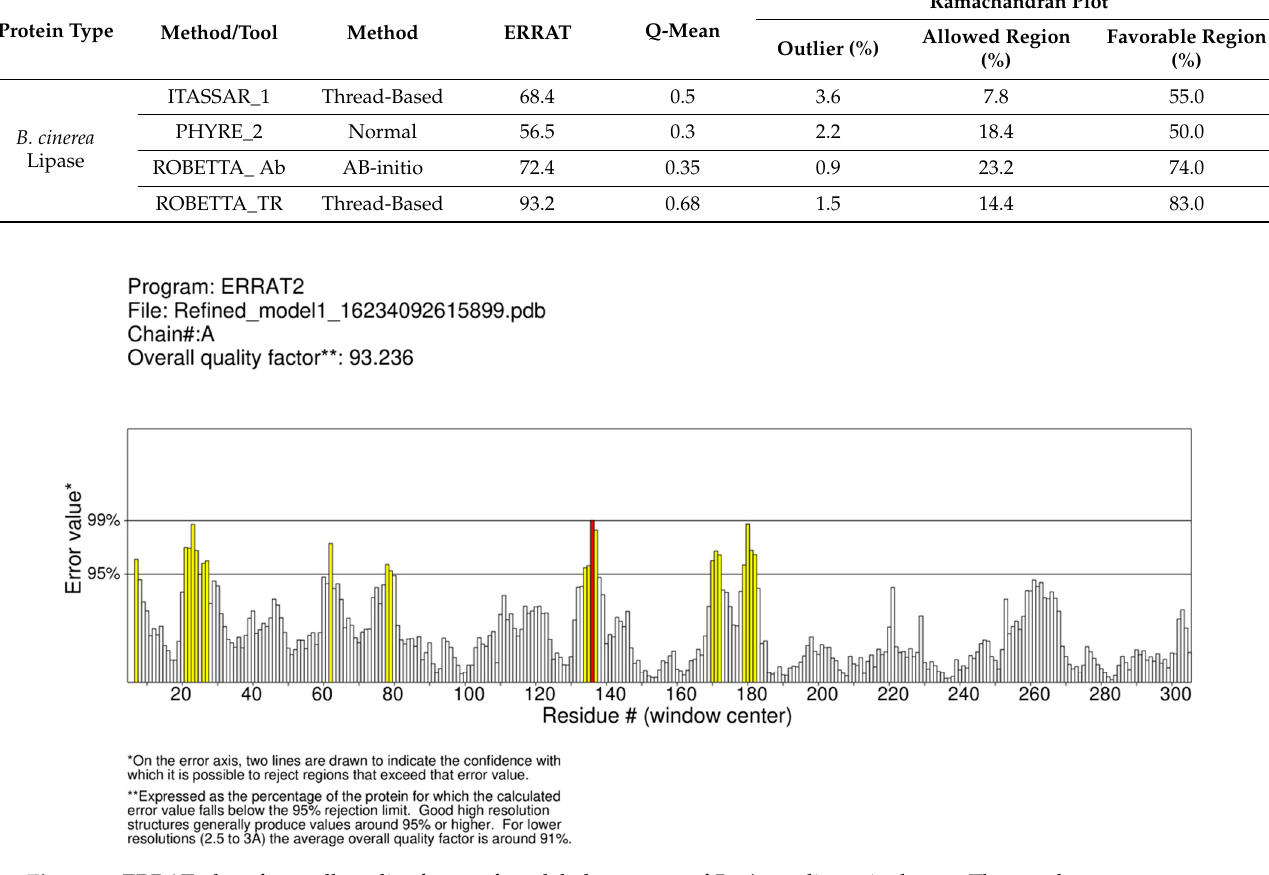
Figure 5. ERRAT plot of overall quality factor of modeled structure of B. cinerea lipase is shown. The graph represents error values of model residues predicted by ERRAT. The “x” axis indicates the amino acid sequences of lipase, while the “y” axis presents the error values.